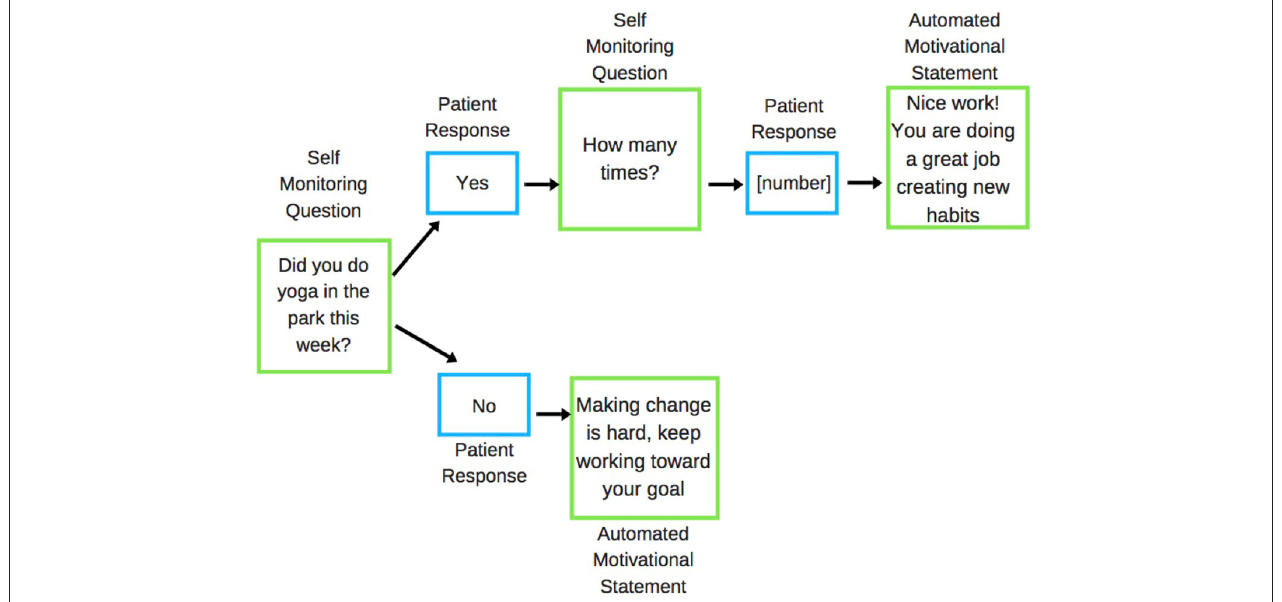
FIGURE 1 | Example of the SMS feedback response system for park prescription interventions. Green boxes are messages sent to patient; blue boxes are messages received from the